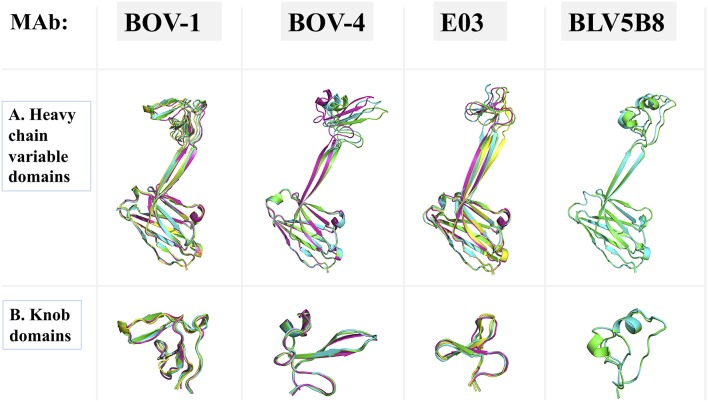
Superimpositions of antibody domains of Fab copies within one asymmetric unit. Fab structures for antibodies BOV-1 and BOV-4 are from this study. BLV5B8 (PDB ID: 4K3E) and E03 (PDB ID: 5IJV) are from Koti et al. (17) and Wang et al. (18), respectively. Copies within one asymmetric unit are represented in cartoon with different colors. (A) Heavy chain variable domains. (B) Knob domains.